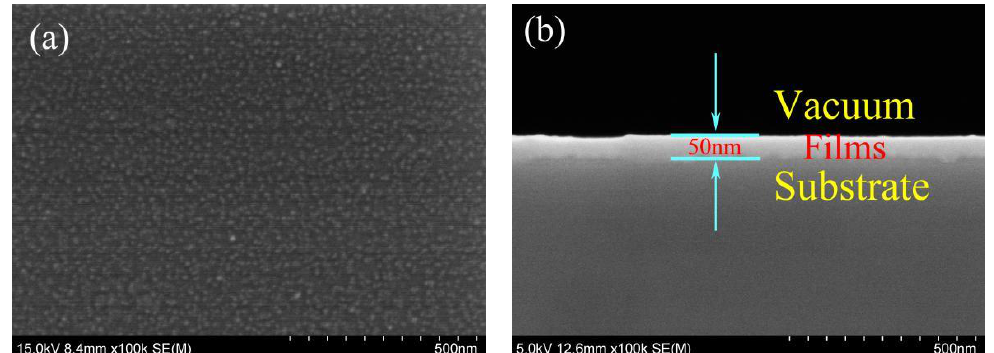
Figure 2. SEM image of the Cu 3 N/MoS 2 composite films: ( a ) surface and ( b ) cross section.